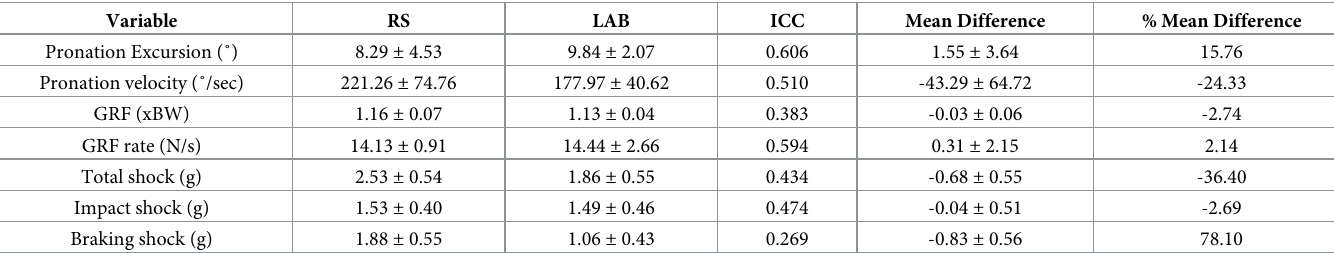
Table 3. Comparison of left foot data from all variables (Mean ± SD), with ICC and mean differences (LAB—RS).